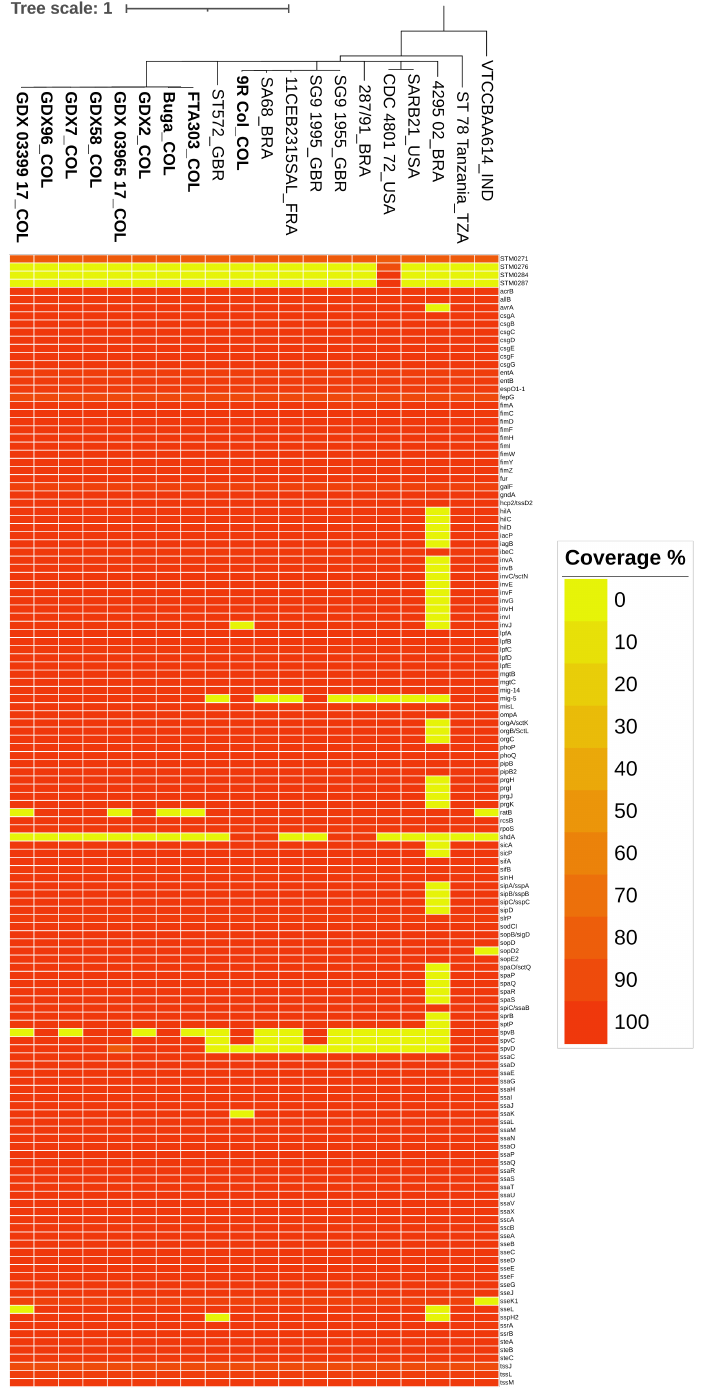
Figure 4. Genes defined as virulence factors identified in the studied SG strains. The color range bar represents the % coverage concerning the VFDB reference. The % coverage values range from 0% (yellow) to 100%